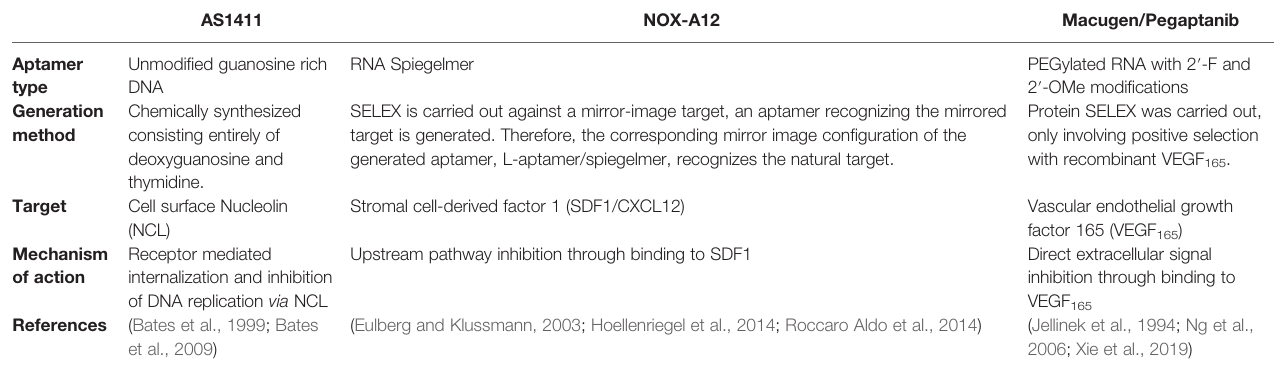
TABLE 3 | Comparison of proli fi c aptamers commonly advertised as promising therapeutic agents for cancer. AS1411